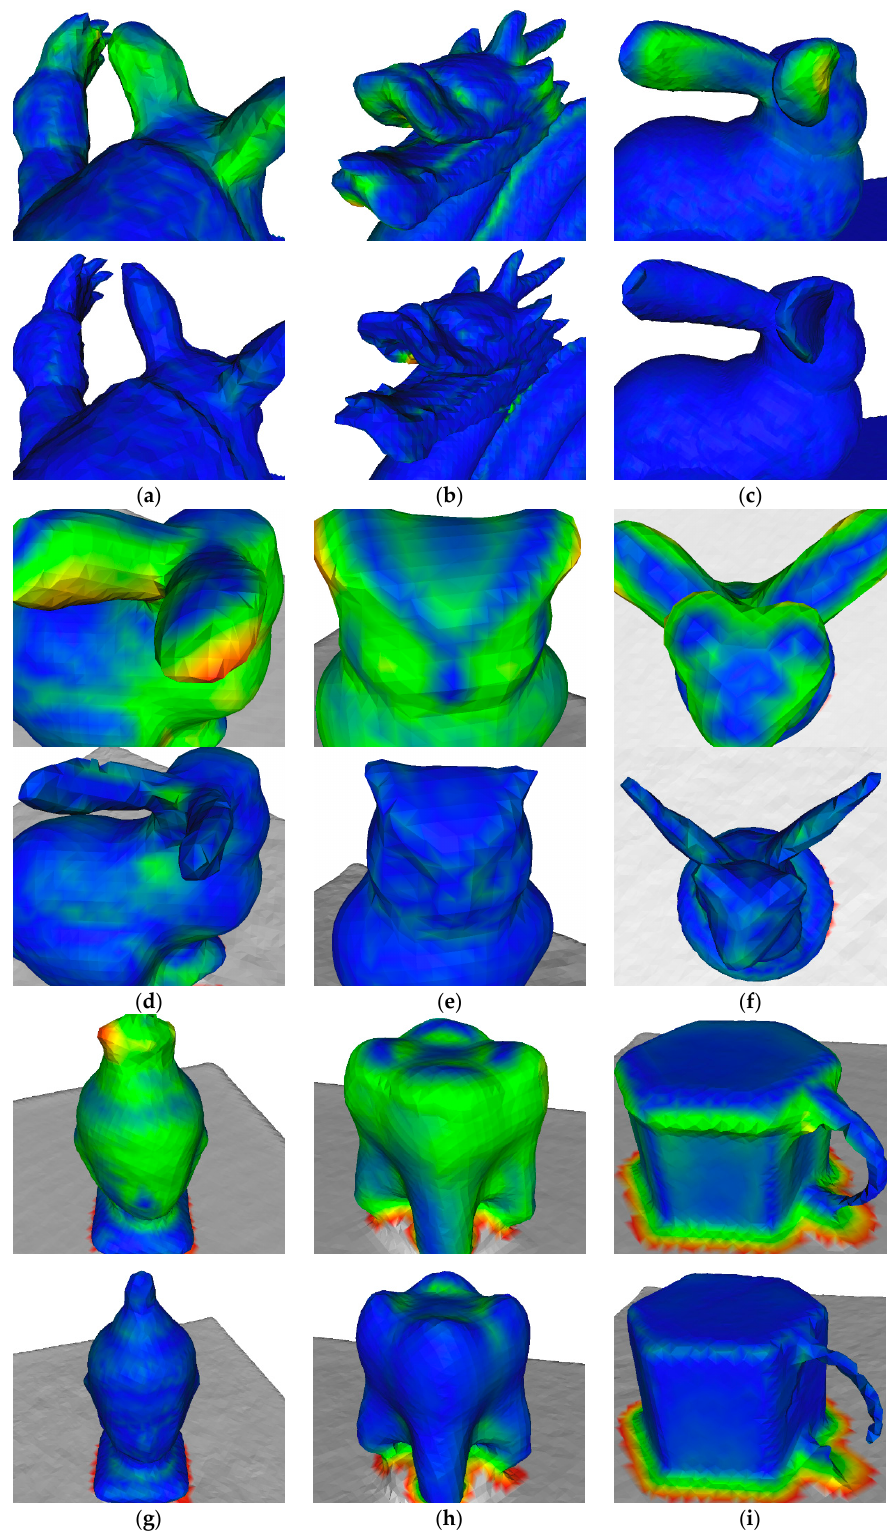
Figure 12. Close-up views of the reconstructions, colored with C2M distances. The synthetic data are ( a ) armadillo; ( b ) dragon; ( c ) bunny; and the real-world data are ( d ) lambunny; ( e ) owl; ( f ) wingedcat; ( g ) buddhahead; ( h ) tooth; and ( i ) mug. The odd rows are reconstructions of KinectFusion [1] as a comparison, and the even rows are of our approach.